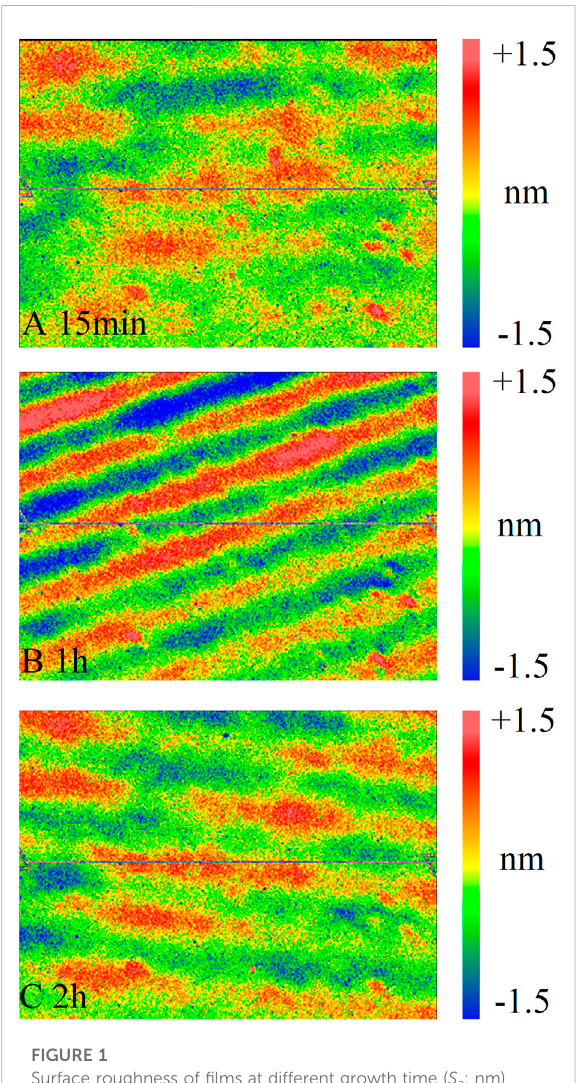
FIGURE 1 Surface roughness of fi lms at different growth time ( S a : nm) (A) for 15 min sample, (B) for 1 h sample and (C) for 2 h